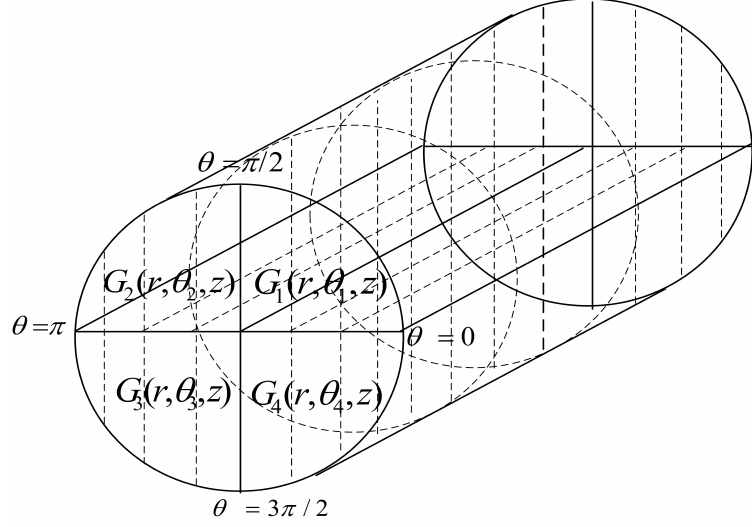
Figure 3. Regions formation in 4-chains based